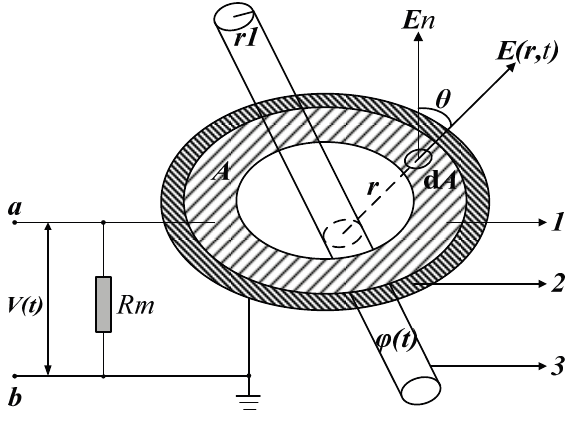
Figure 3. Measurement principle of electric field coupling